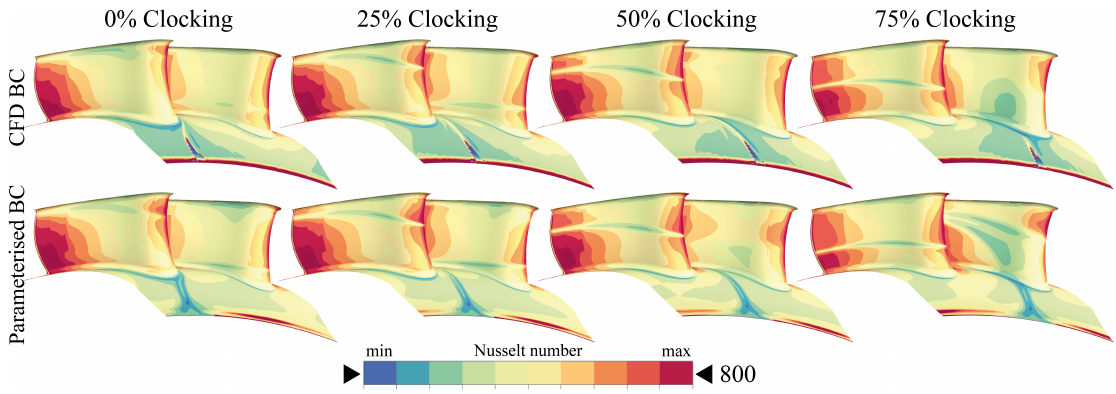
Figure 14. Comparison of the Nusselt